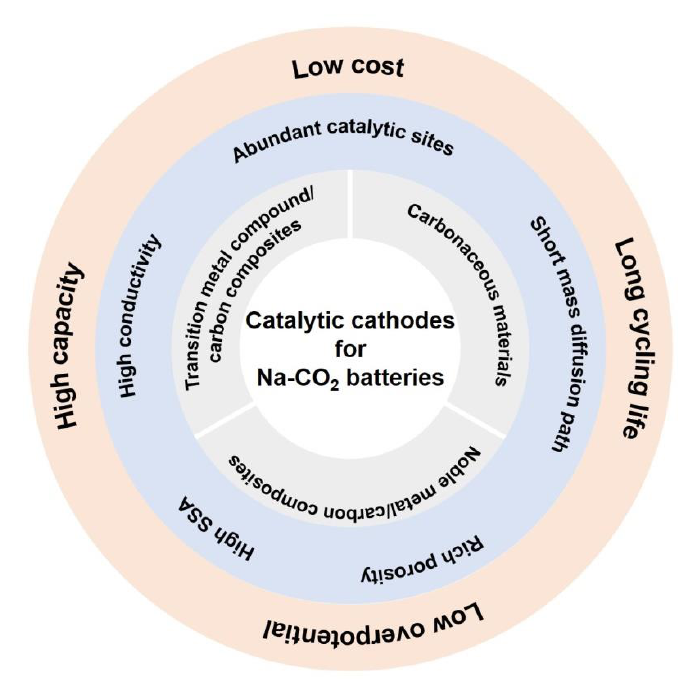
Figure 2. Effective catalytic cathode materials for high-performance Na-CO 2 batteries.